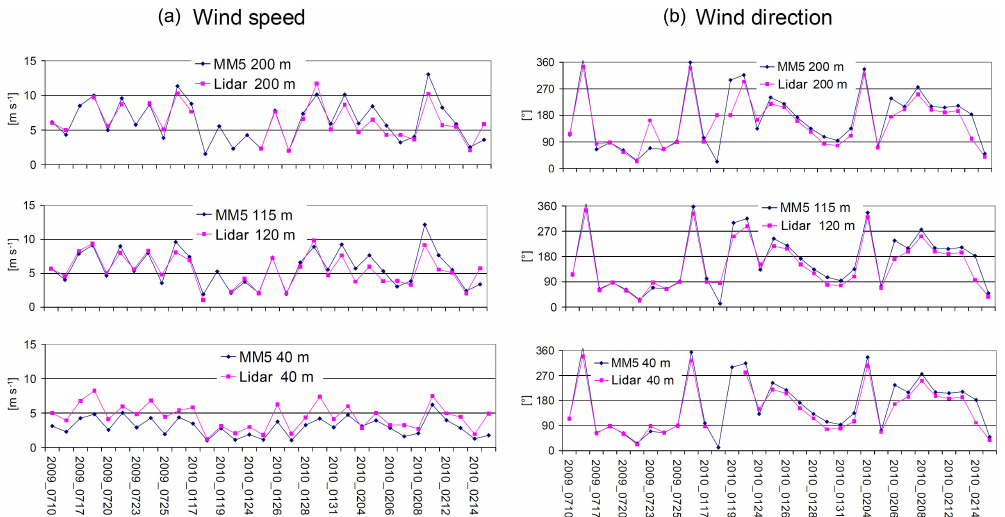
Figure A1. Comparison of the wind fields ( a : speed; b : direction) derived from the MM5 model and the wind lidar at the SIRTA site at Palaiseu in the south-west of Paris for three altitude levels.